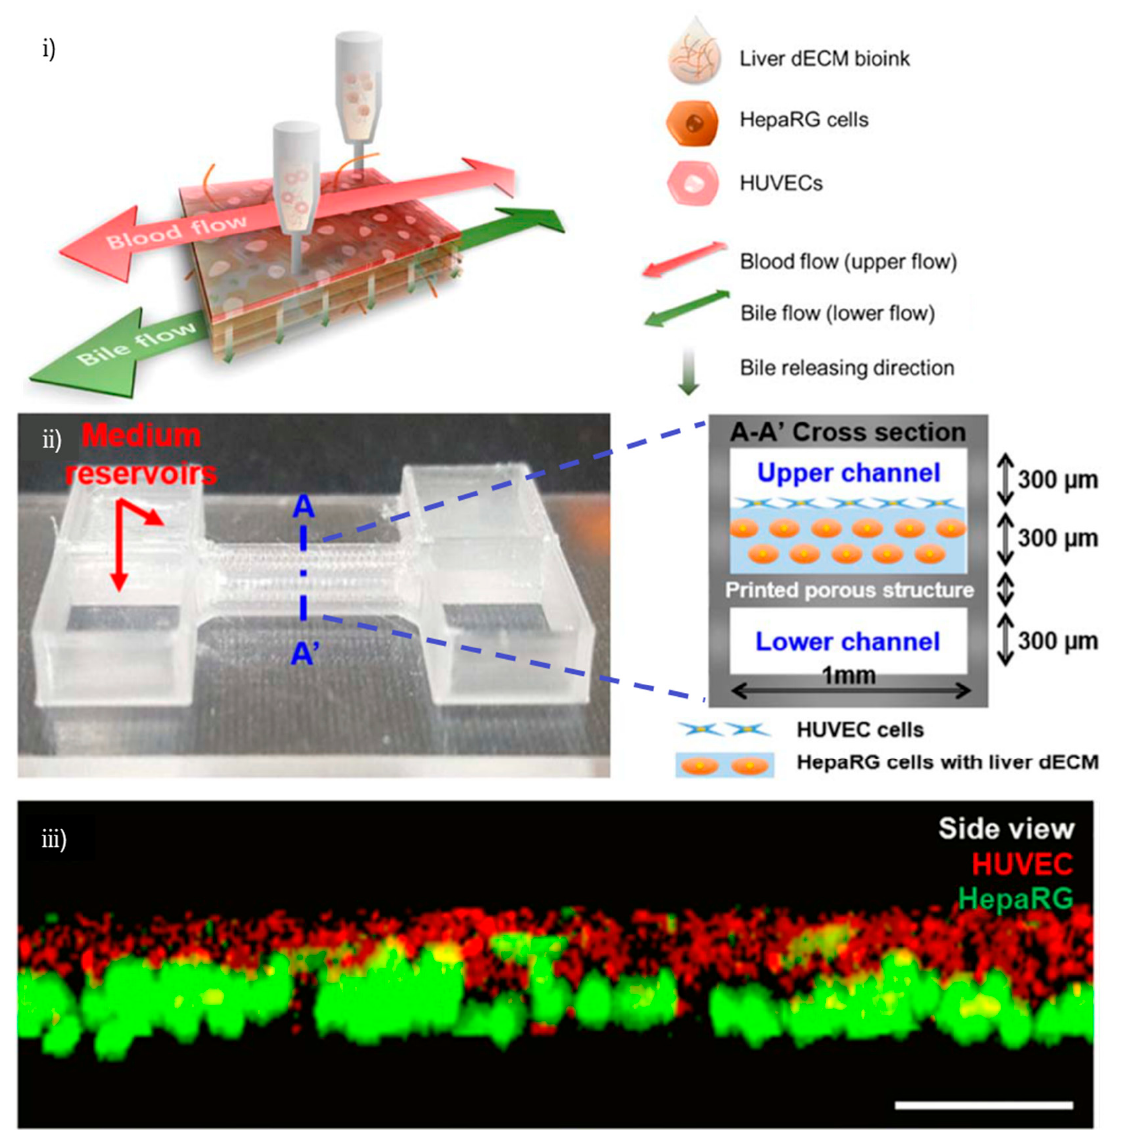
Figure 11. Three-dimensional printing and modeling of liver-on-chip microenvironment for in vitro testing: ( i ) schematic 3D bioprinted layer by layer representation; ( ii ) cell-printed 3D liver-on-a-chip microfluidic device with dual fluidic feature; ( iii ) analysis of cell positioning after cell printing (side view of the channel). Reprinted and edited with permission granted by Copyright Clearance Center, Inc. (“CCC”). Published in Biofabrication by IOP Publishing Ltd. Authors: H. Lee et al. Title: “Cell-printed 3D liver-on-a-chip possessing a liver microenvironment and biliary system”, Figures 1, 3 and 4 [85].